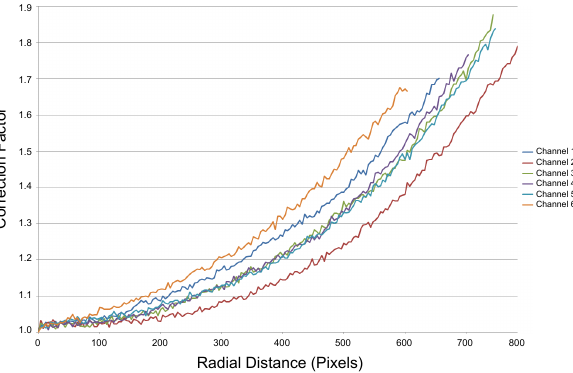
Figure 7: Rate of Correction Factor Change Flat field imagery was generated for each of the six